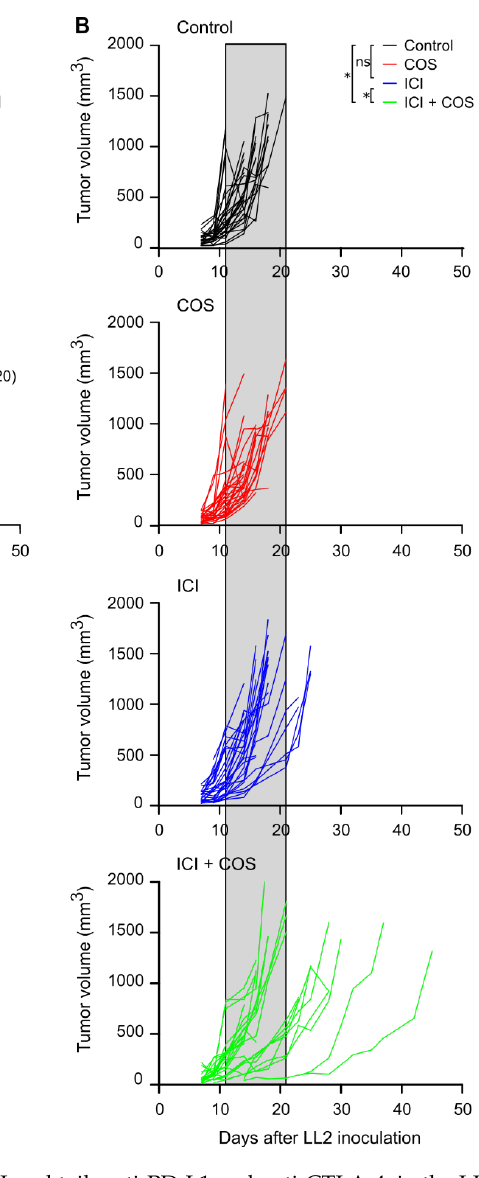
Figure 3. COS improve the efficacy of an ICI cocktail, anti-PD-L1 and anti-CTLA-4, in the LL2 lung cancer model. ( A ) Treatment regimen and experimental setup of tumor study. ( B ) Individual tumor growth curves for C57BL/6 mice inoculated with 5 × 10 5 LL2 cancer cells ( n = 30 per group). Shaded areas included for easy comparison of the different groups represent the terminal tumor growth time frame of the control group. ( C ) Kaplan–Meier plot of survival curves. ( D ) Plasma YKL-40 levels at time of sacrifice ( n = 10 per group) (mean). * p < 0.05, *** p < 0.001, according to Mann–Whitney U